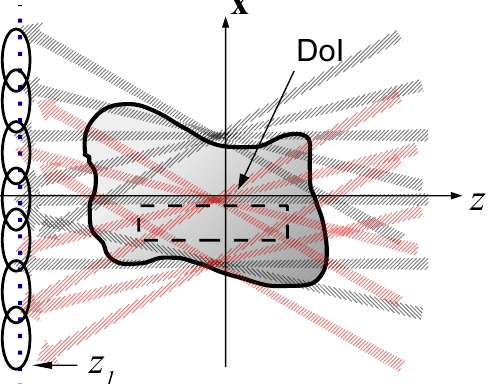
Figure 6. An overview of the local inversion algorithm. The beam expansion of the scattered field is plotted as gray arrows. Only those covering the array are plotted. The scattering data is then transformed to beam amplitudes by stacking the receivers data via (30), as schematized by the black ellipses. Only beams with high amplitude are considered and backpropagated via (31). The image in the DoI (black rectangle) is obtained by aggregating the contribution of beams that pass inside the DoI (red